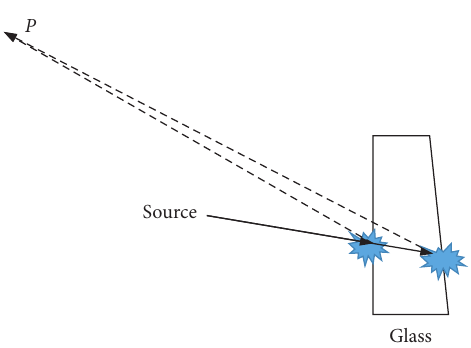
Figure 2: The calculating model of the optical characteristics of stray light.